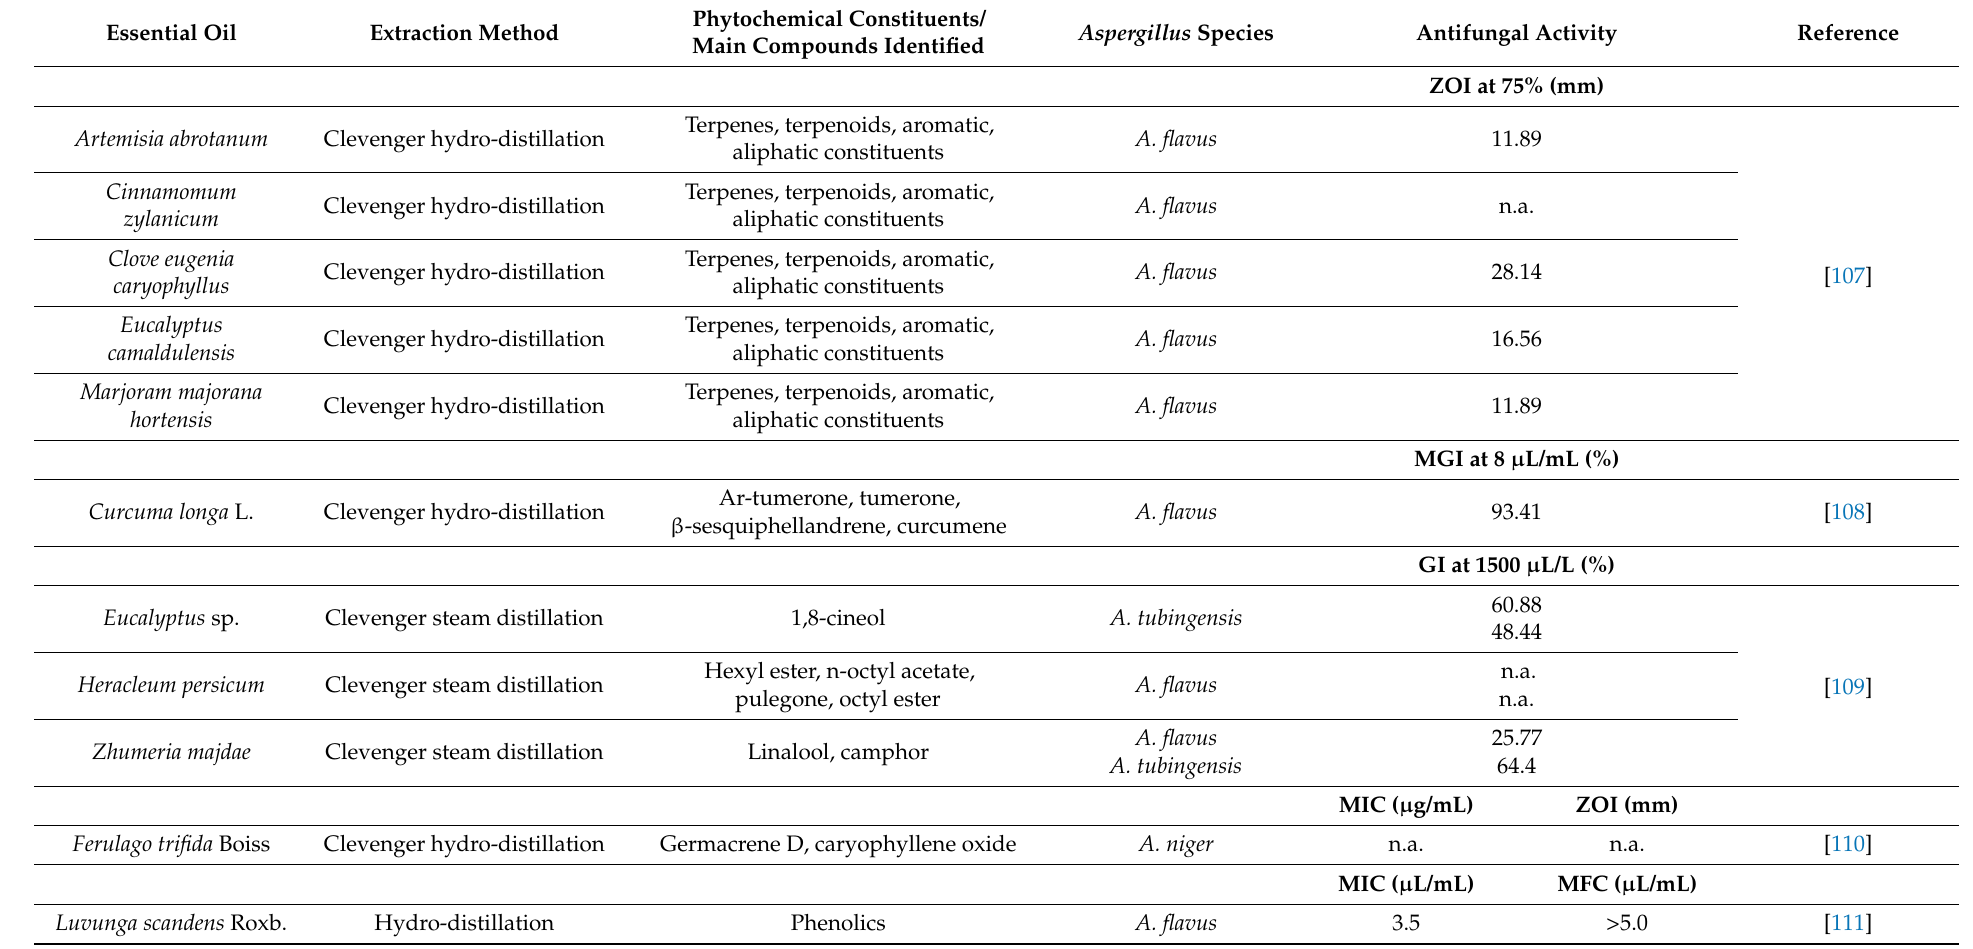
Table 2. Antifungal effects of essential oils against Aspergillus